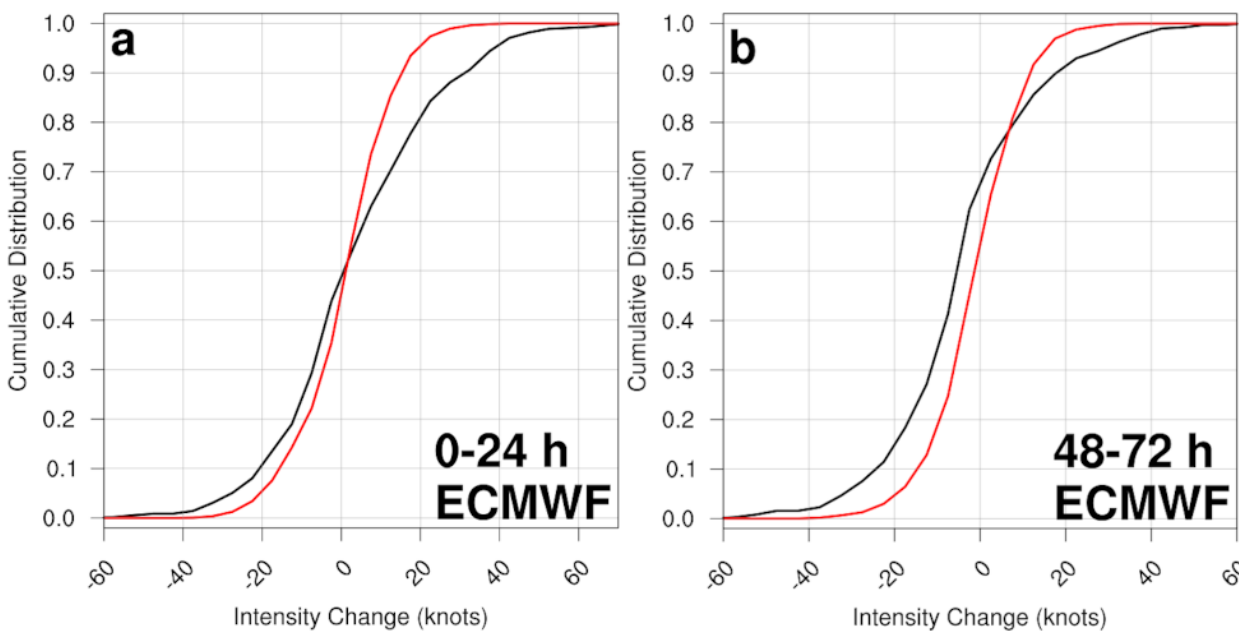
Figure 8. 0-24 h ECMWF maximum wind speed change CDFs based on retrospective forecasts from the 2017–2018 seasons (red line). The black line denotes the corresponding best track maximum wind speed change CDF. ( b ) as in ( a ), but for the 48–72 h